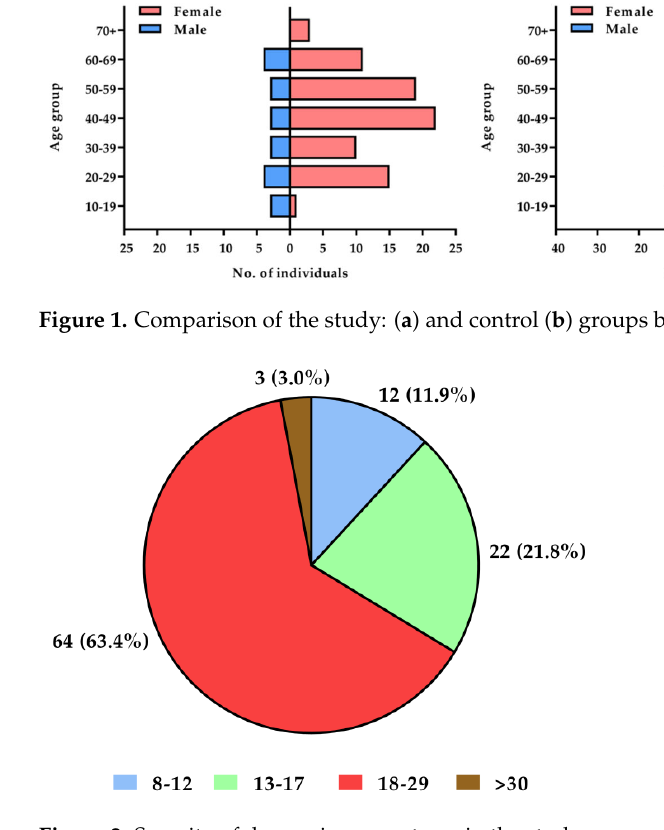
Figure 2. Severity of depression symptoms in the study group according to the HDRS (Hamilton De- pression Scale) test. Interpretation of results: <7—no symptoms of depressive disorders; 8–12—mild severity; 13–17—moderate severity; 18–29—severe severity; >30—very severe intensification of depressive disorders